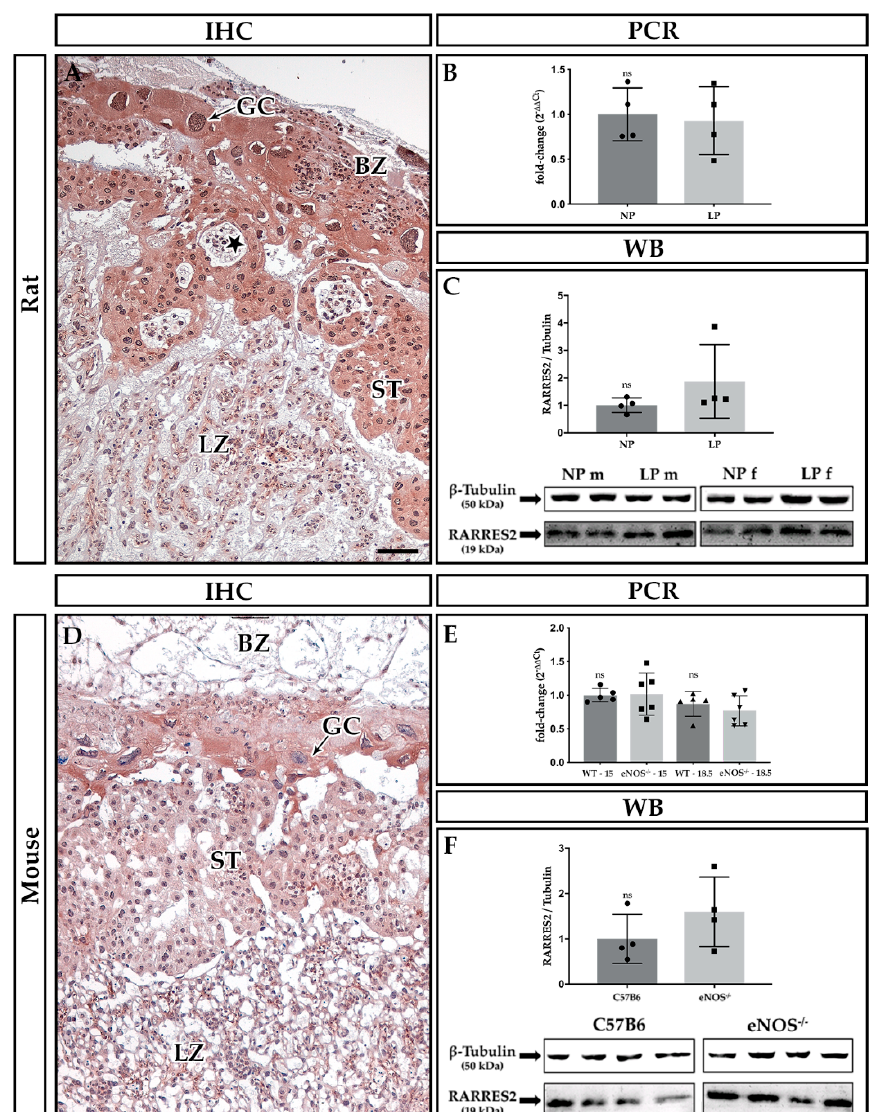
Figure 2. Rarres2 expression in rat and mouse placenta. ( A − C ) Rat placenta, ( D − F ) mouse placenta. ( A , D ) Immunohistochemical (IHC) stains of methyl Carnoy-fixed placental paraffin sections. Abbreviations: GC = giant cell, BZ = basal zone, ST = spongiotrophoblast, LZ = labyrinth zone, star